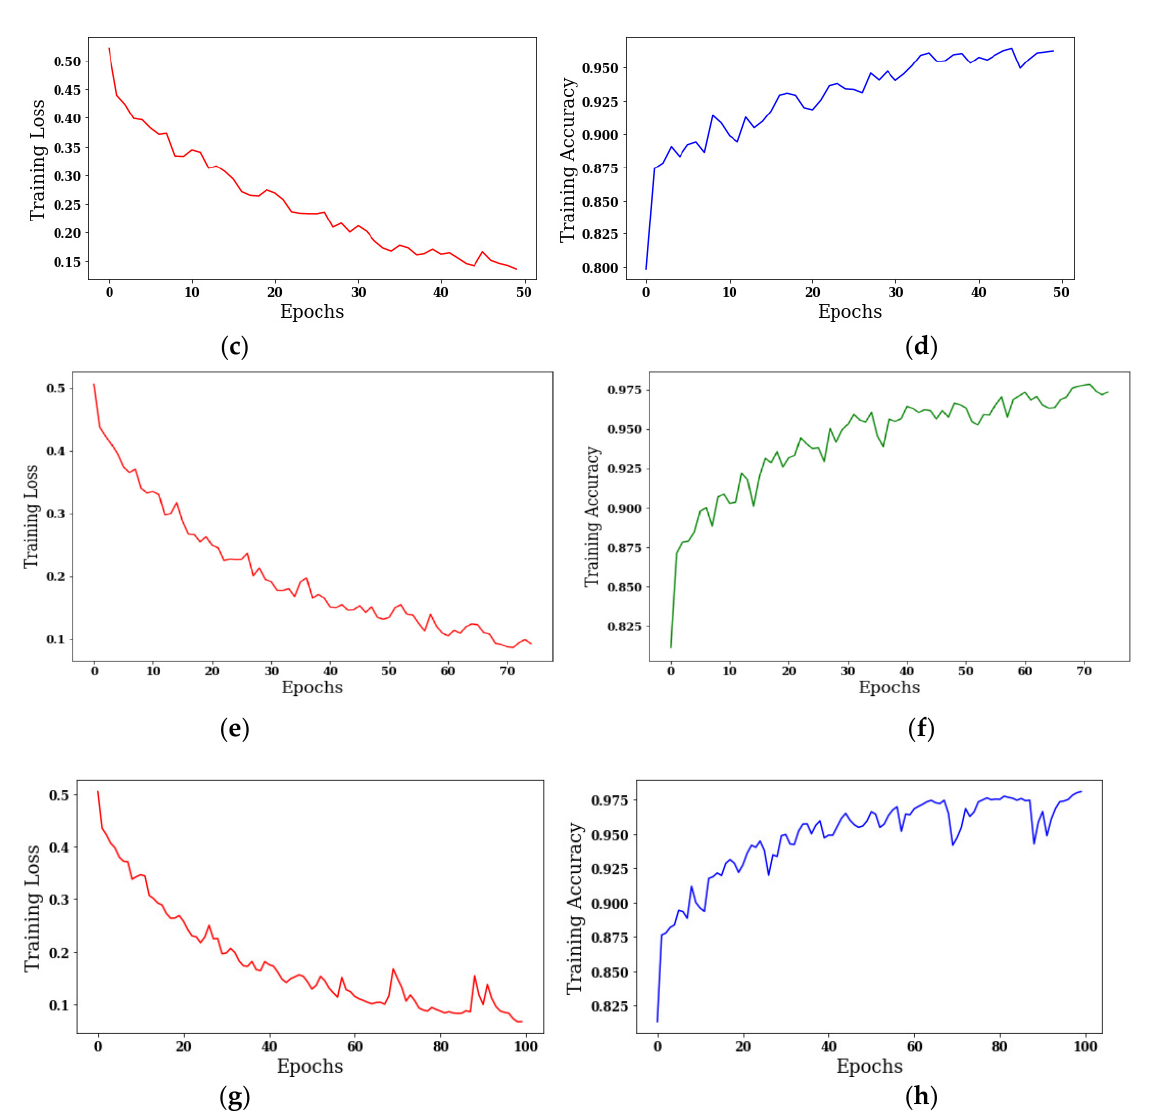
Figure 11. Analysis of training loss and training accuracy: ( a ) Training Loss on 25 epochs; ( b ) Training Accuracy on 25 epochs; ( c ) Training Loss on 50 epochs; ( d ) Training Accuracy on 50 epochs; ( e ) Training Loss on 75 epochs; ( f ) Training Accuracy on 75 epochs; ( g ) Training Loss on 100 epochs; ( h ) Training Accuracy on 100 epochs.